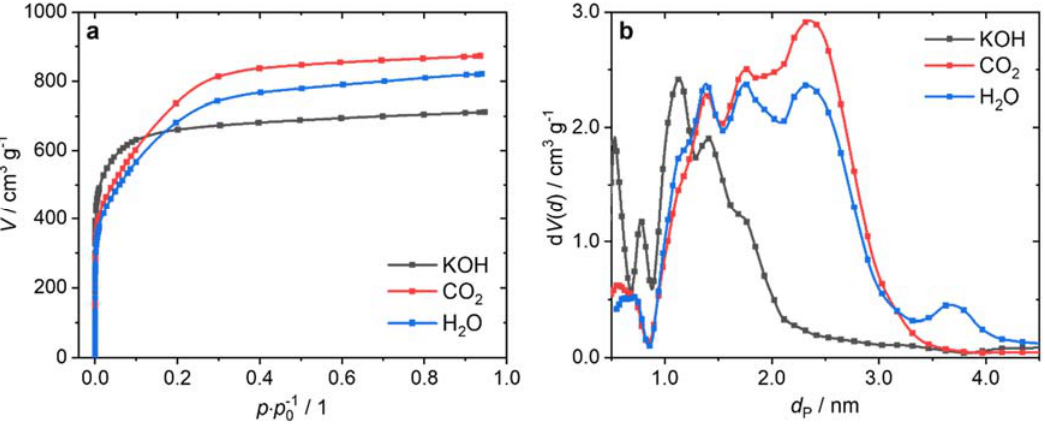
Figure 1. Isotherms ( a ) and PSDs ( b ) of the ACFs activated with KOH, CO 2 , and H 2 O (N 2 ; 77 K; NLDFT; slit ‐ pore model).